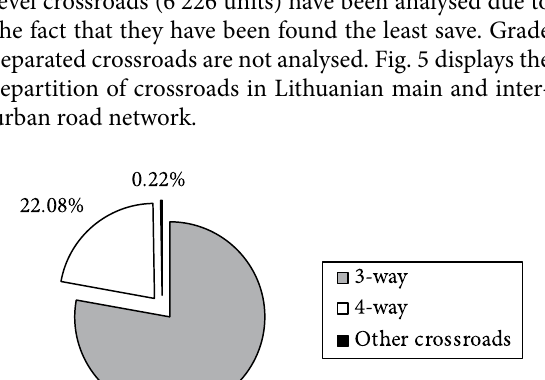
are displayed in Table 7: AR C – calculated accident rate.